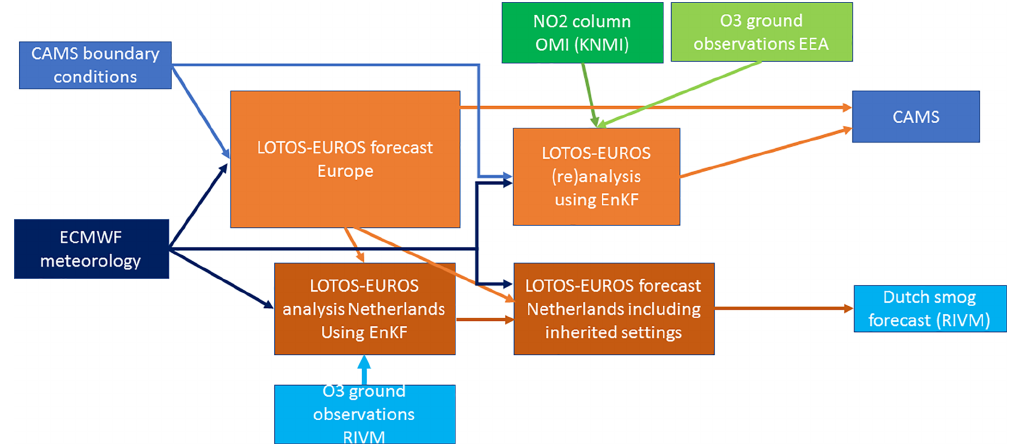
Figure 2. Schematic view of operational suite at KNMI for the production of air quality analysis and forecasts with LOTOS–EUROS for Europe as used for CAMS and for the official Dutch air quality information service as used by RIVM. In data assimilations ground observations of ozone (and NO 2 column) are included and the European-scale simulation serves as boundary condition for the higher- resolution simulation for the Netherlands. The figure also illustrates the natural cooperation between TNO, KNMI and RIVM for air quality